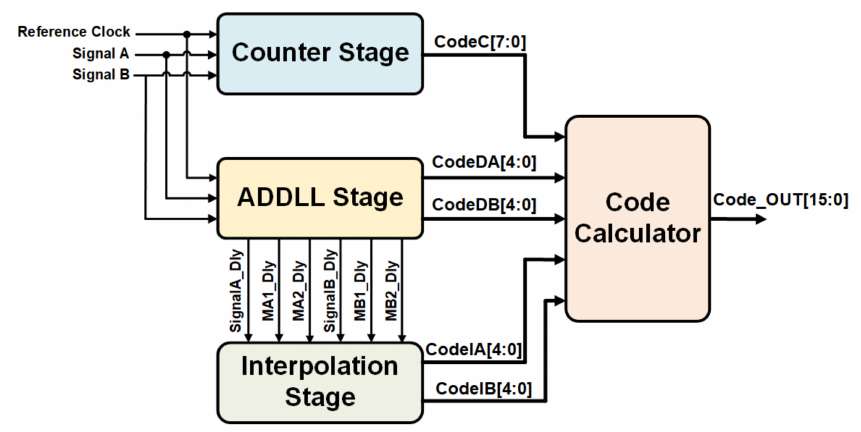
Figure 2. The proposed timing-monitor